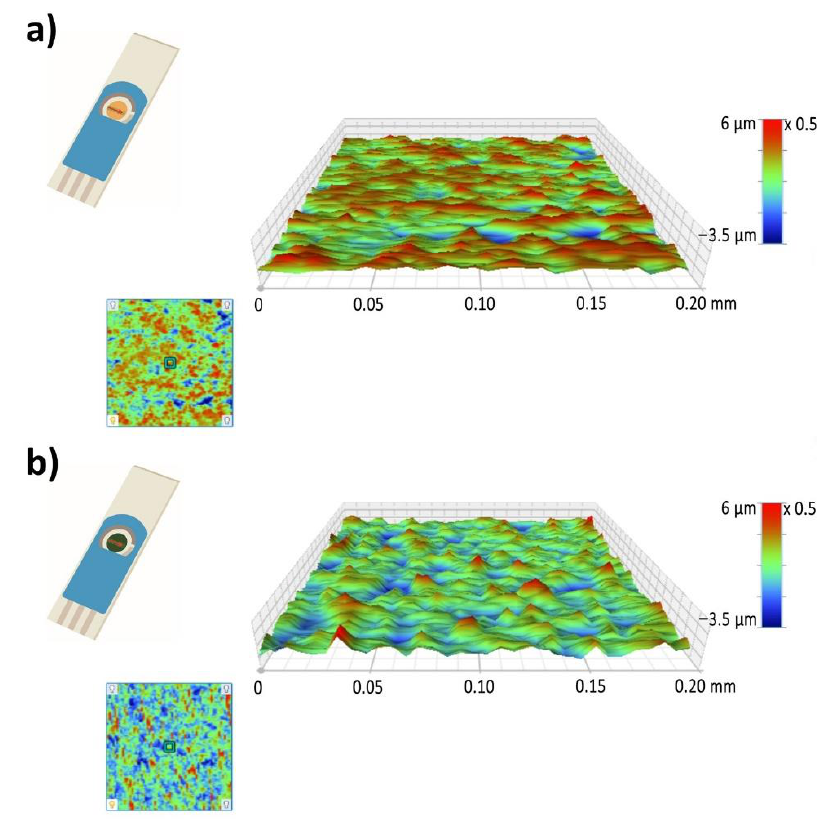
Figure 5. Three-dimensional (3D) mapping of surface area: ( a ) Au-SPE and ( b ) PANI-Au-SPE.